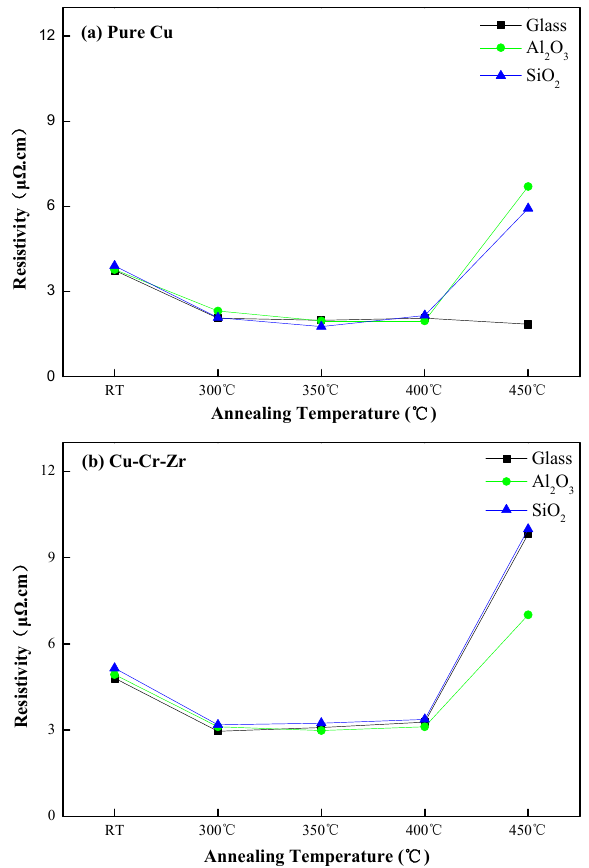
Figure 2. Resistivity on different substrates with different annealing temperatures: ( a ) Pure Cu; ( b ) Cu-Cr-Zr.